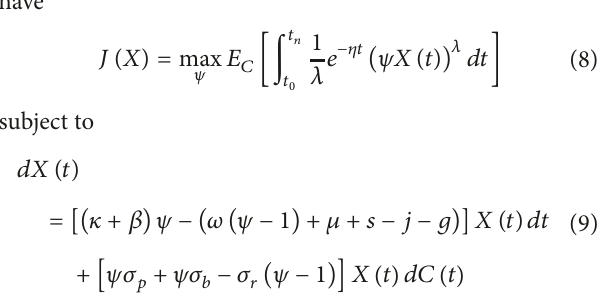
Table 4 is computed from Table